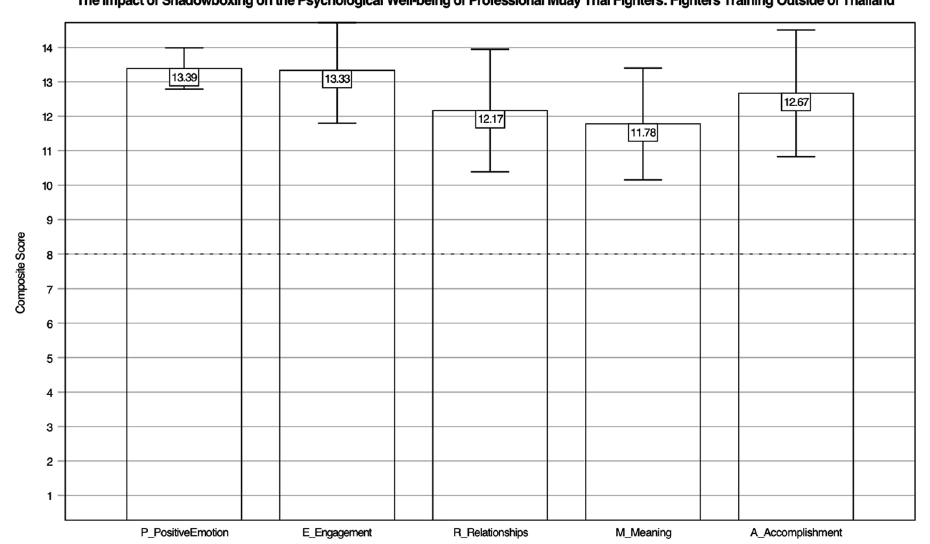
Fig. 7 This figure provides a bar plot with 95% confidence intervals (CIs) for composite PERMA scores: Nak Muays training outside of Thai- land (n = 9). For each element of psychological well-being, the lowest possible composite score is 2 representing that professional Nak Muays strongly agree that shadowboxing negatively impacts that element of psychological well-being, whereas the highest possible com- posite score is 14 representing that professional Nak Muays strongly agree that shadowboxing positively impacts that element of psycho- logical well-being. A composite score of 8 (dotted line) reflects a neutral position on whether shadowboxing contributes positively or nega- tively to that element. Results in this figure show that Nak Muays training outside of Thailand strongly agree that shadowboxing positively contributes to all elements of their psychological well-being. Further, results in this figure show that shadowboxing contributes to the ele- ments of psychological well-being in the following rank-order for Nak Muays training outside of Thailand: positive emotions (P), engage- ment (E), accomplishment (A), relationships (R), and meaning